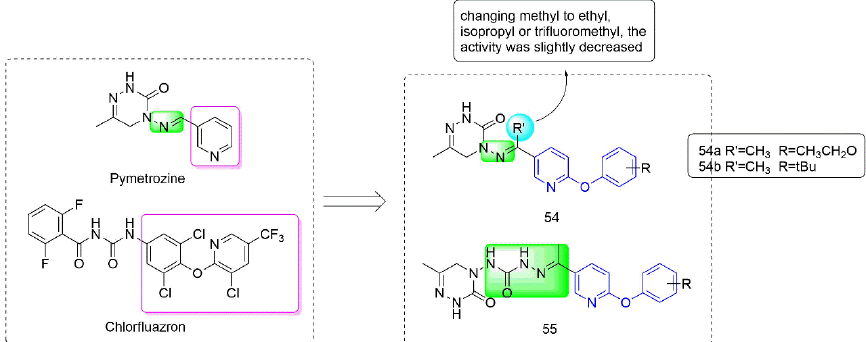
Figure 11. Transient receptor potential vanilloid channel blockers containing